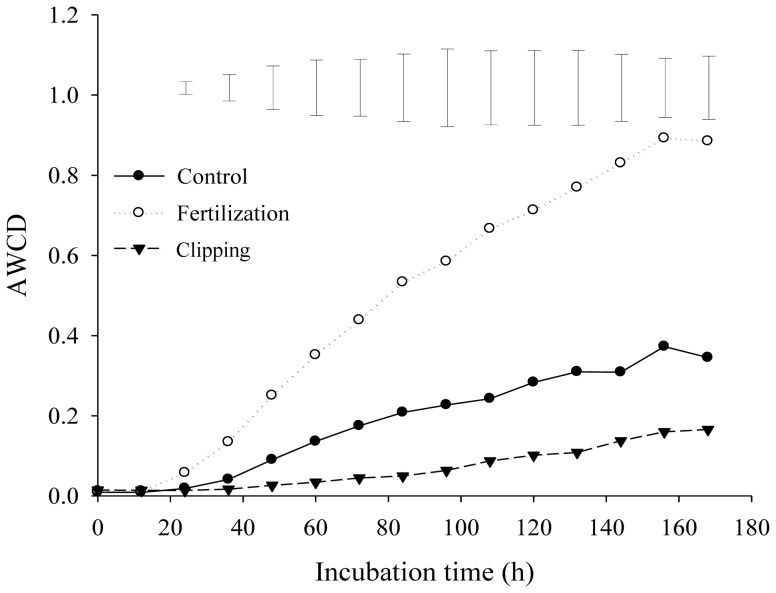
Change of average well color development (AWCD) of soil microbial community during the incubation time in July, 2012.Vertical bars represent Fisher's protected LSD (p<0.05).